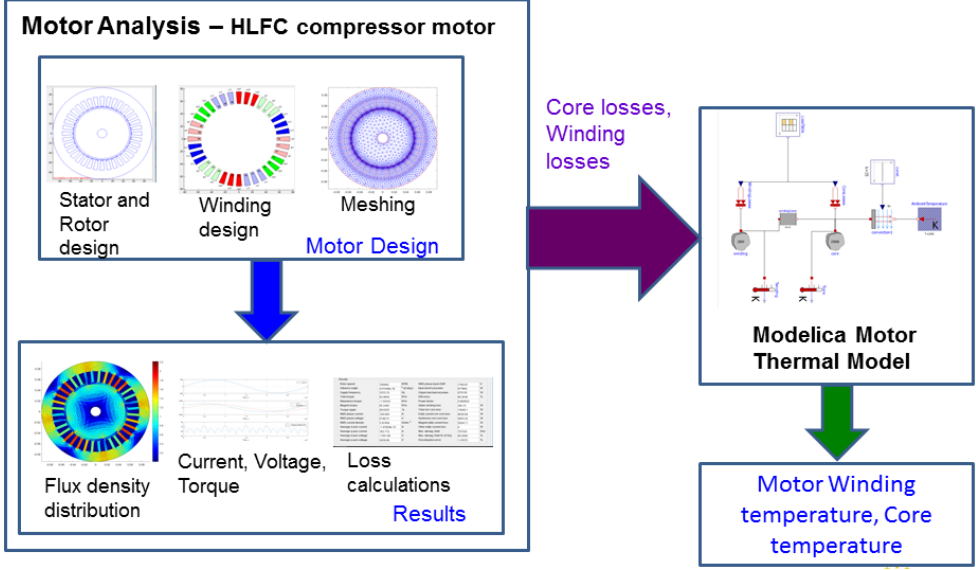
Figure 19. Thermal analysis method used for the permanent magnet synchronous motor.